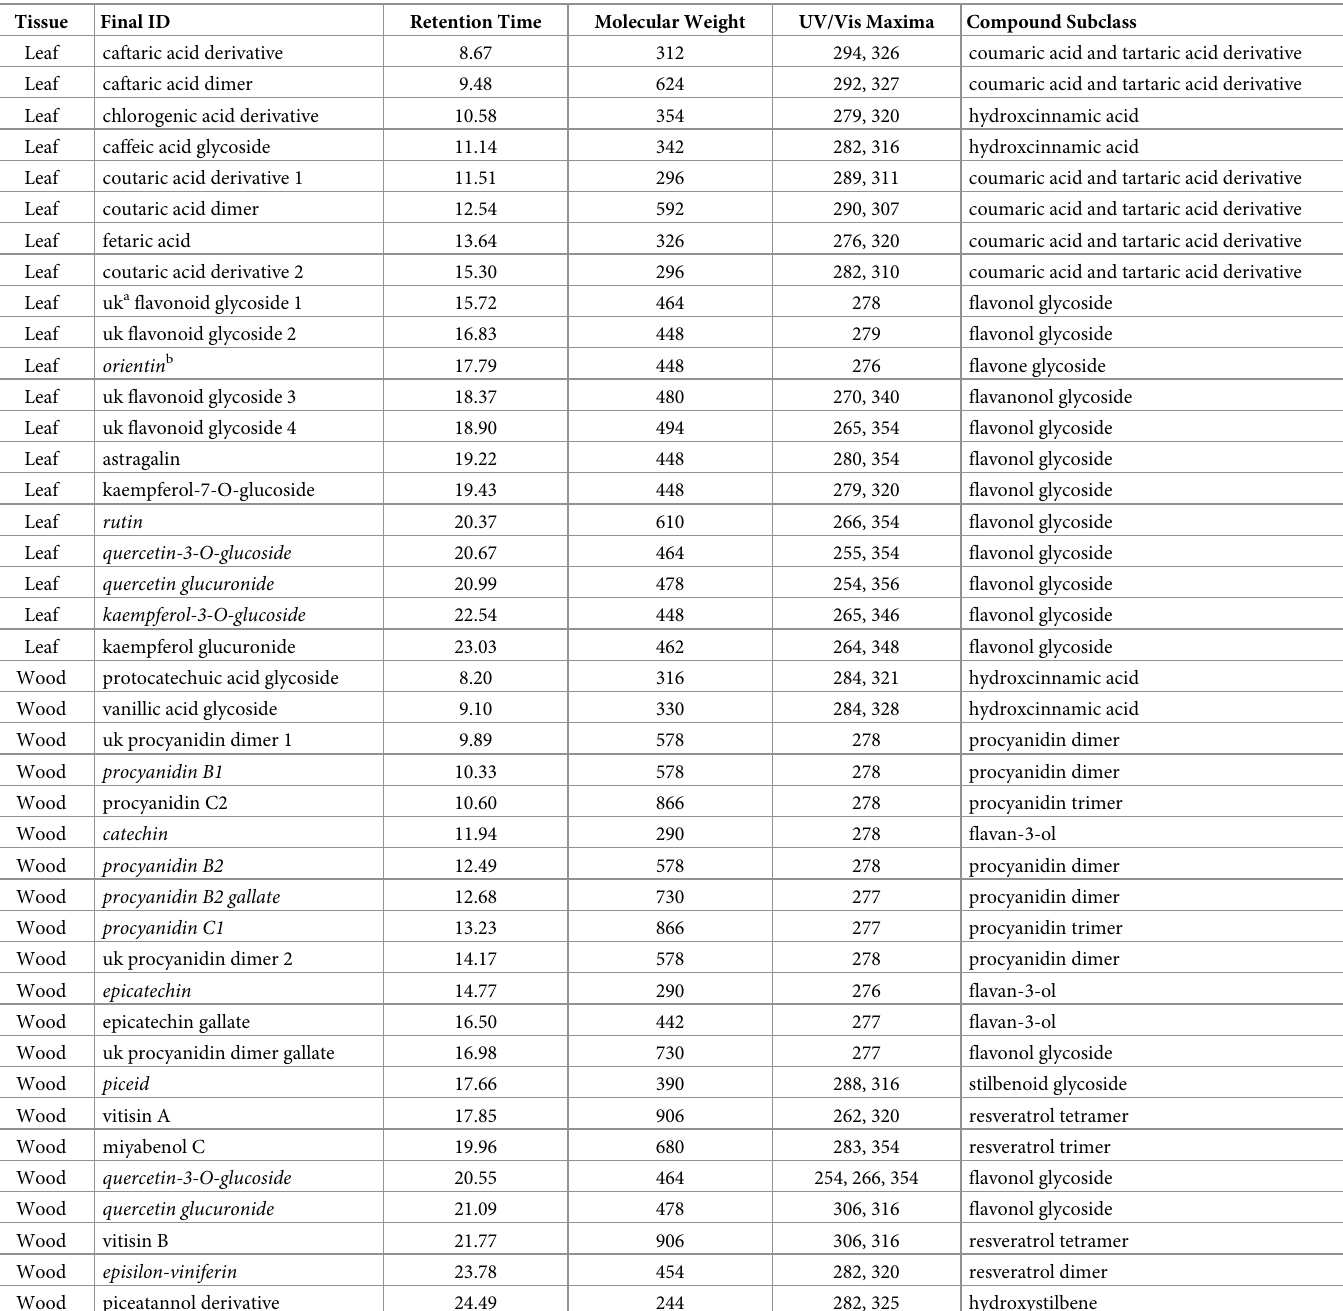
Table 1. Compounds quantified in this study with identification criteria